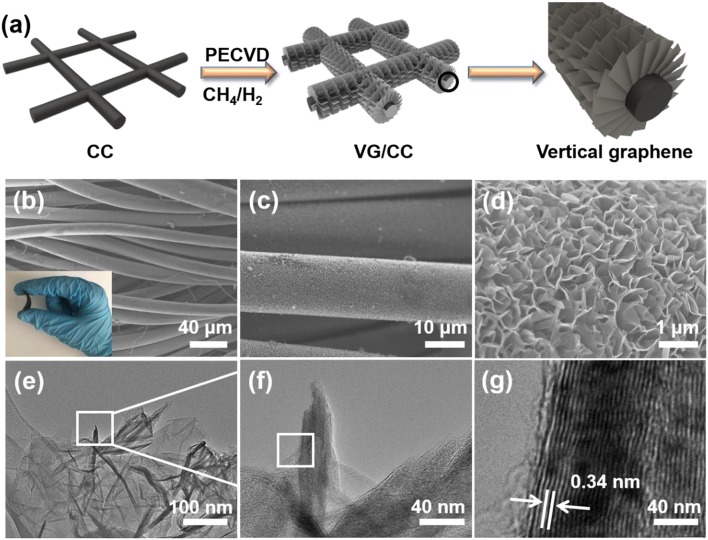
(a) Schematic illustration of the synthesis process of the VG/CC by PECVD. (b) Low, (c) high, and (d) higher magnification SEM images of VG/CC. Insets: photograph of bent VG/CC, demonstrating the good mechanical strength of VG/CC. TEM image of VG/CC at (e) low and (f) high magnifications, (g) HRTEM images of VG/CC.